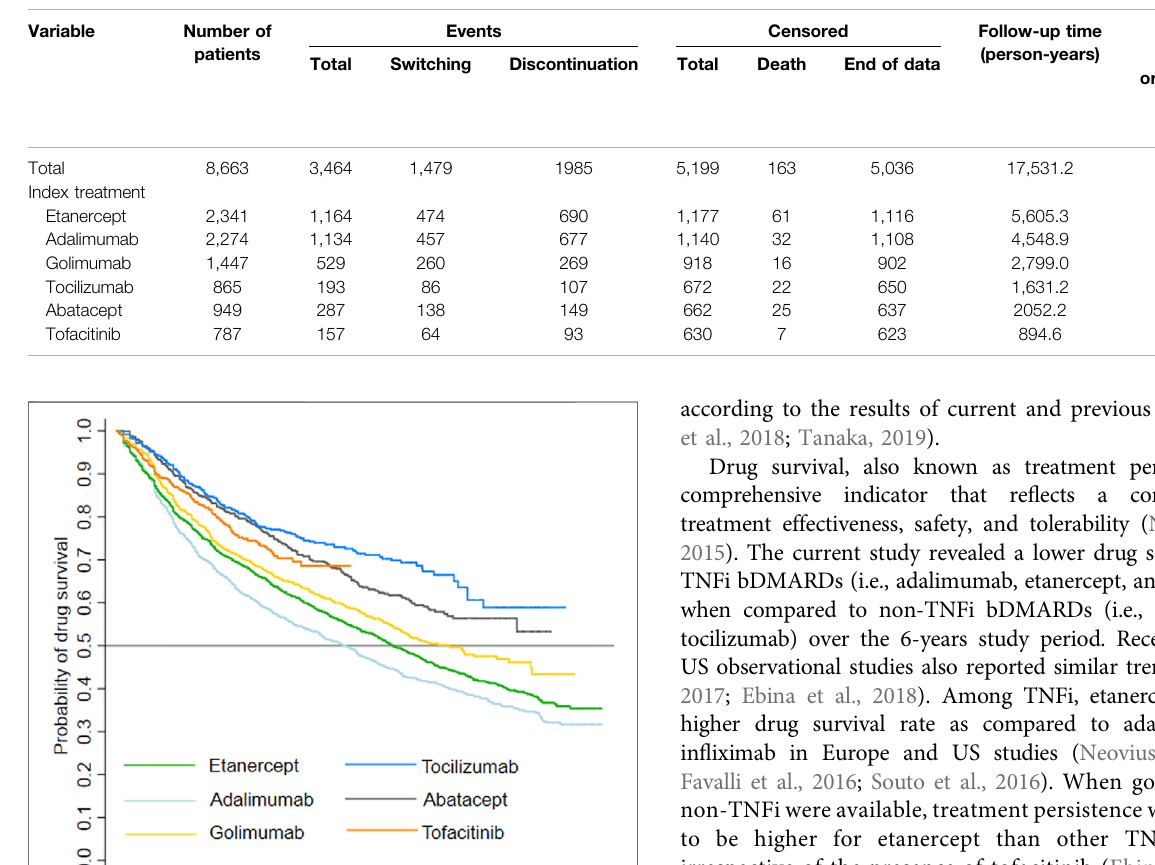
TABLE 2 | Events and incidence rate of switching or discontinuation.